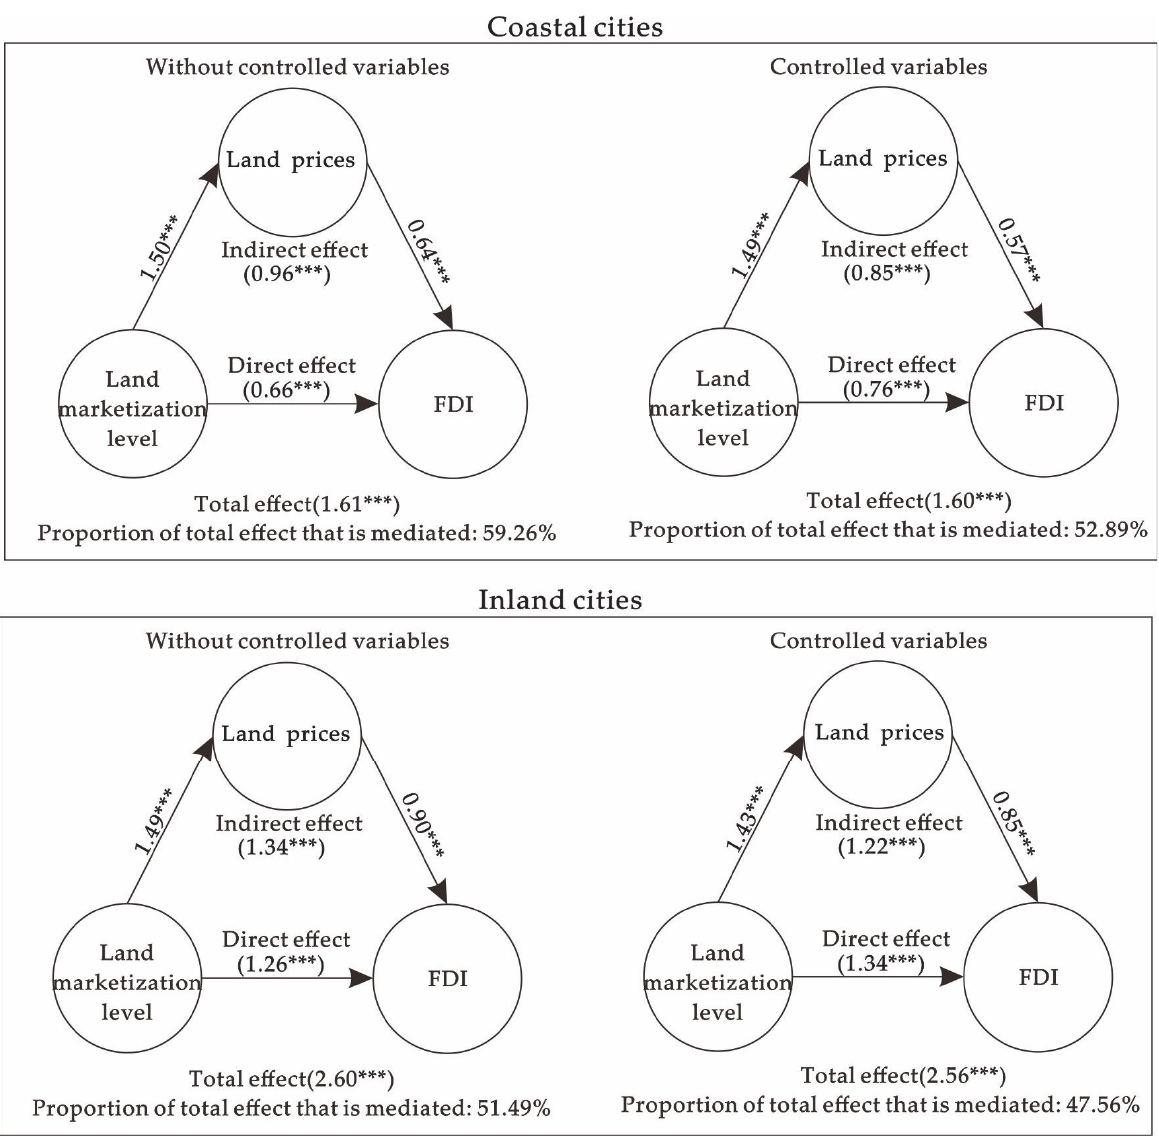
Figure 9. Effects of land marketization level and land prices on FDI in coastal and inland cities. Note: *** p < 0.01.